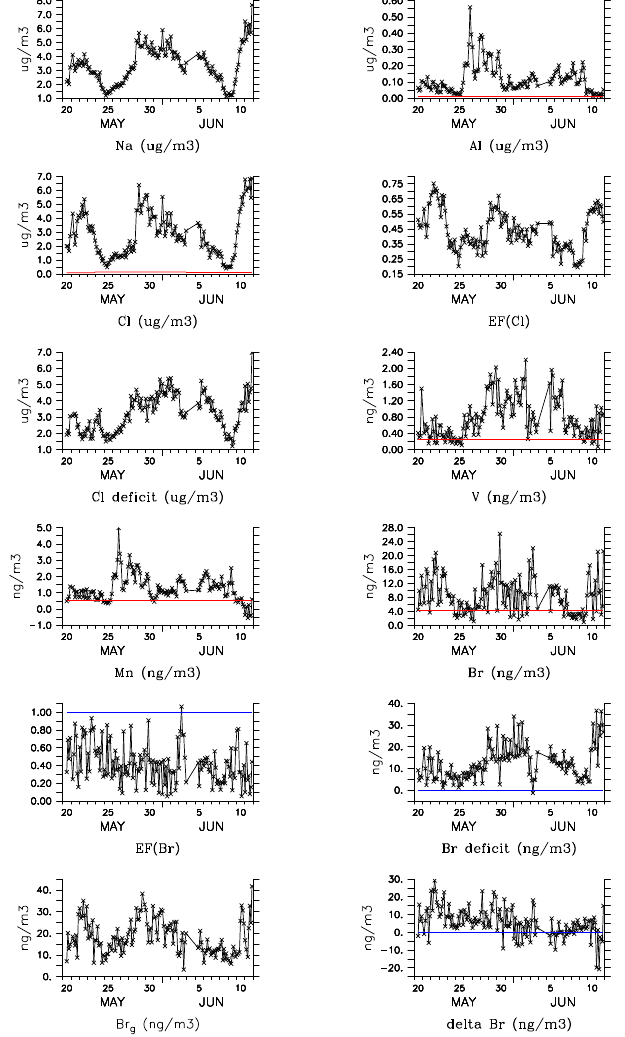
Figure 6. Time series of the filter pack data, analyzed by NAA. The red lines denote the detection limit and the blue lines denote sea water composition, i.e., EF = 1 and deficit =